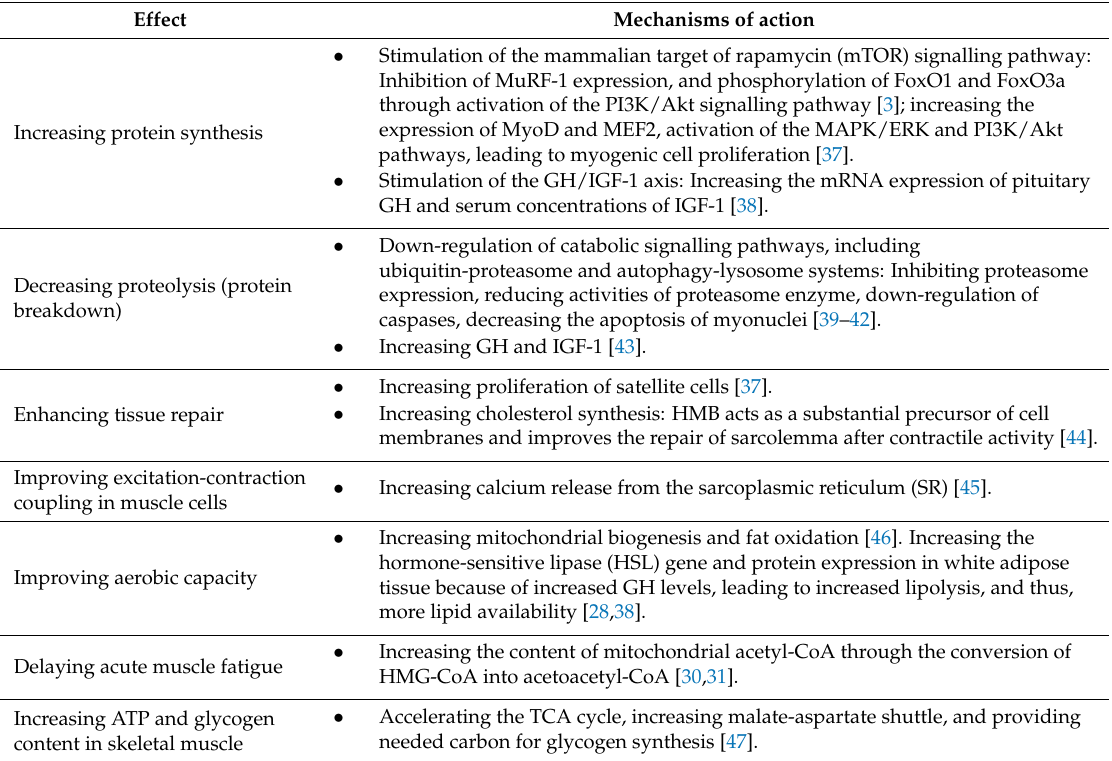
Table 1. A summary of potential mechanisms proposed for the different beneficial effects of HMB supplementation on skeletal